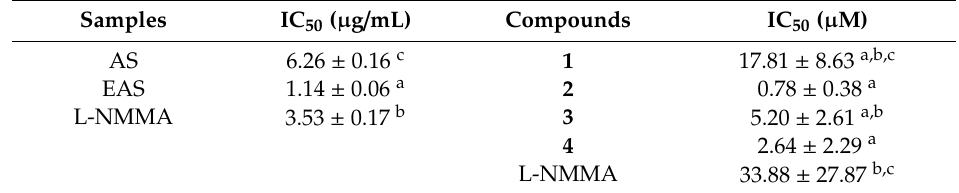
Table 3. IC 50 values of AS, EAS, and the isolated compounds for the inhibitory activity on NO production.